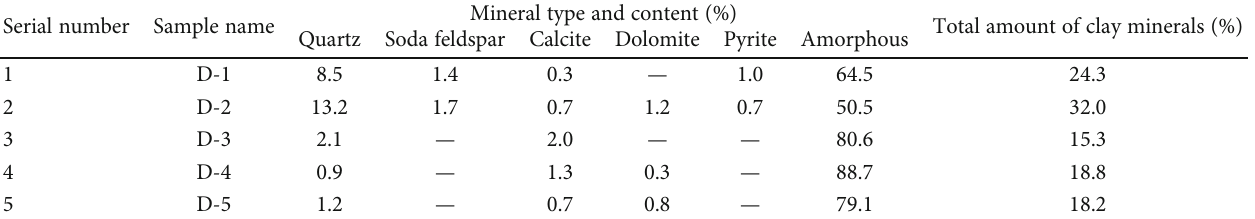
Figure 1: Experimental coal sample. Table 1: Rock mineral analysis.